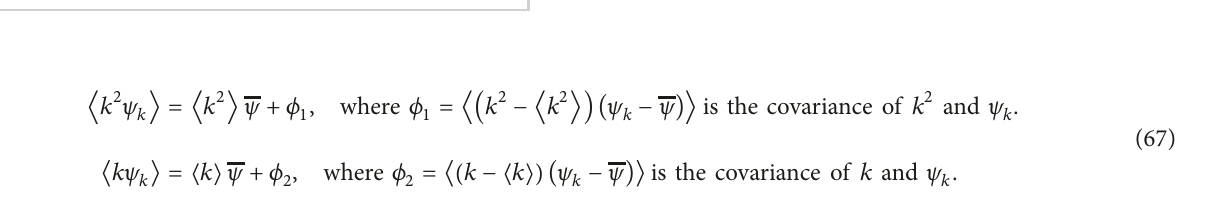
the increase of the value of 𝑑 , which leads to an increase in the number of infected peers; if 𝑅 0 < 1 , the number of infected peers decreases rapidly with the increase of the value of 𝑑 and drops to zero eventually. To control the spread of passive worms, we need to restrict the number of hops a search can reach in addition to changing the network